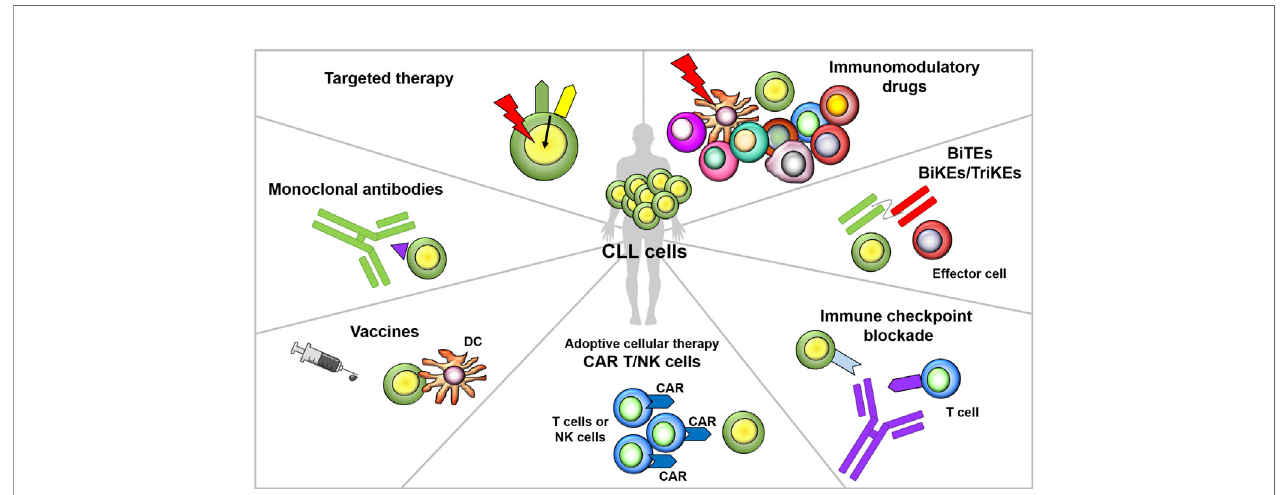
FIGURE 2 | Overview of immunomodulatory agents and immune-based strategies in CLL. Several immunotherapeutic strategies are under evaluation in CLL. Targeted drugs, in addition to a direct anti-tumor activity, can exert off-tumor immunomodulatory effects on T cells and other immune elements. Immunomodulatory drugs (IMiDs) exert their activity through a broad immunomodulation and pleiotropic effects on multiple elements of the immune system (e.g, T, B, NK cells and DC). Monoclonal antibodies act through the recognition of a speci fi c antigen expressed on the surface of tumor cells, which leads to the triggering of cytotoxic responses. Bi- and tri-speci fi c killer cell engagers contain two or three antigen-recognition domains, and are designed to concomitantly target a tumor cell antigen and a molecule expressed on the surface of effectors cells, with the aim of directing immune cell activity toward malignant cells. Cancer vaccines aim at inducing tumor- speci fi c T-cell immunity in an antigen-dependent fashion, thus eliciting immunological memory and long-term protection against cancer relapse. CAR T cells are autologous T lymphocytes engineered to express a chimeric receptor, which recognizes a tumor surface antigen; upon antigen recognition and co-stimulatory domains activation, a cytotoxic response is triggered, leading to tumor cells killing. Immune checkpoint inhibitors target the interactions between co-inhibitory receptors and their ligands thus avoiding the transmission of inhibitory signals that render T cells functionally